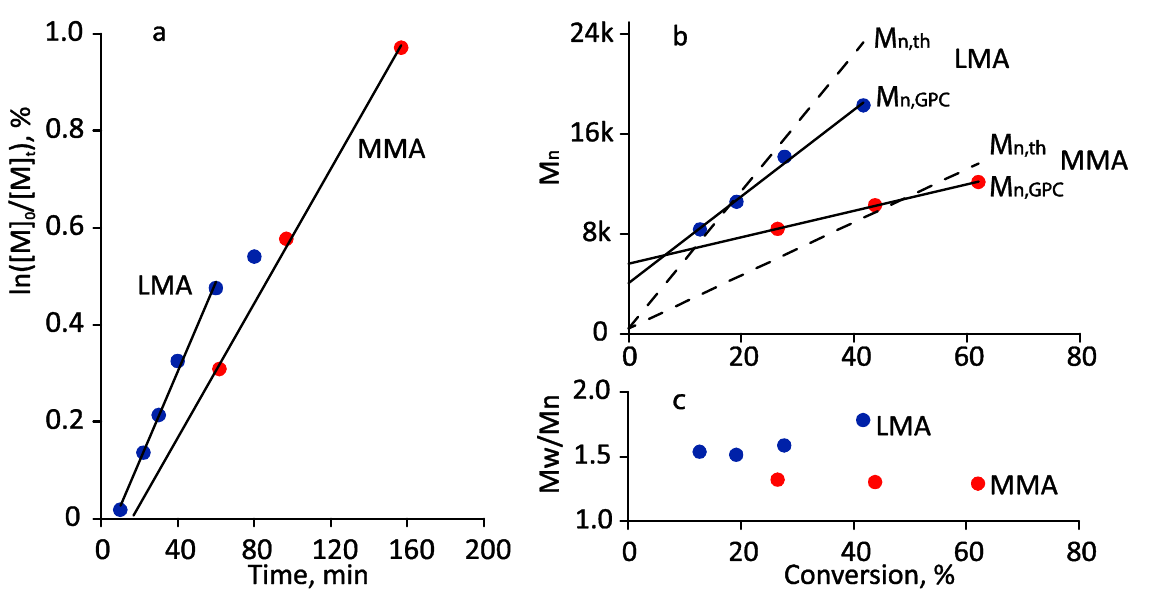
Figure 7. Kinetic first-order plot ( a ), and the plot of M n,UV , M n,th , M n,GPC and M W /M n vs. conversion ( b ) for the photo-induced RAFT copolymerization of MPEGMA and AOEGMA in toluene (Ph11). Polymerization conditions: ω MPEGMA = 50 wt.%, [MPEGMA] 0 /[AOEGMA] 0 /[CDTPA] 0 = 100:100:1, blue LED, 8.3 mW/cm 2 , 35 °C.